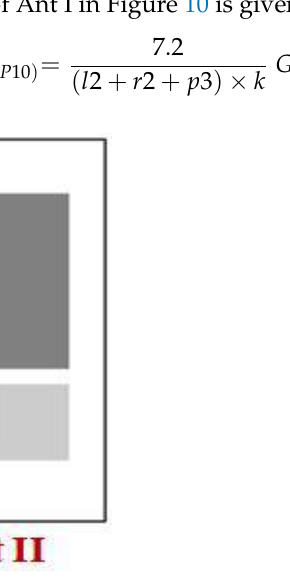
Figure 10. Evolution of the antennas linked with P10 to P17.